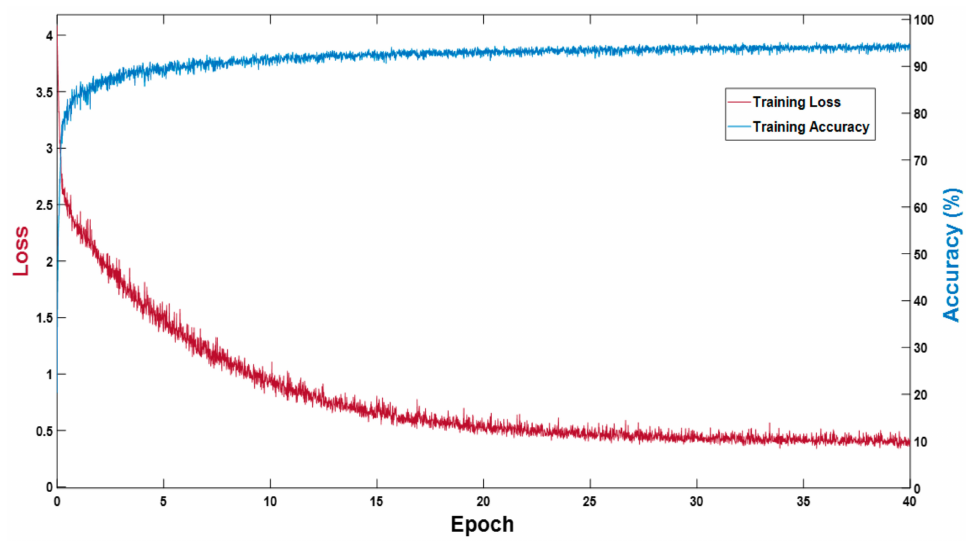
Figure 5. MASS-Net training accuracy-loss